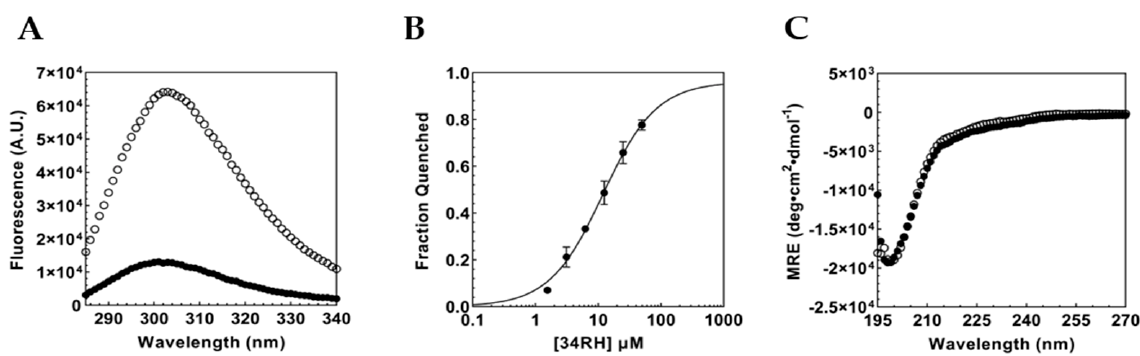
Figure 2. ( A ) Inner filter corrected fluorescence emission spectrum of 1 μ M Myc 402–412 peptide with (black circles) and without (white circles) 50 μ M 34RH. ( B ) Fraction quenched titration curve for 1 μ M Myc 402–412 peptide and 34RH fitted to a Langmuir binding isotherm yielding a K D = 11.5 ± 1.2 μ M. Error bars represent the standard error of three independent trials. ( C ) CD spectrum of 2.5 μ M Myc 402–412 peptide with (black circles) and without (white circles) 50 μ M 34RH.